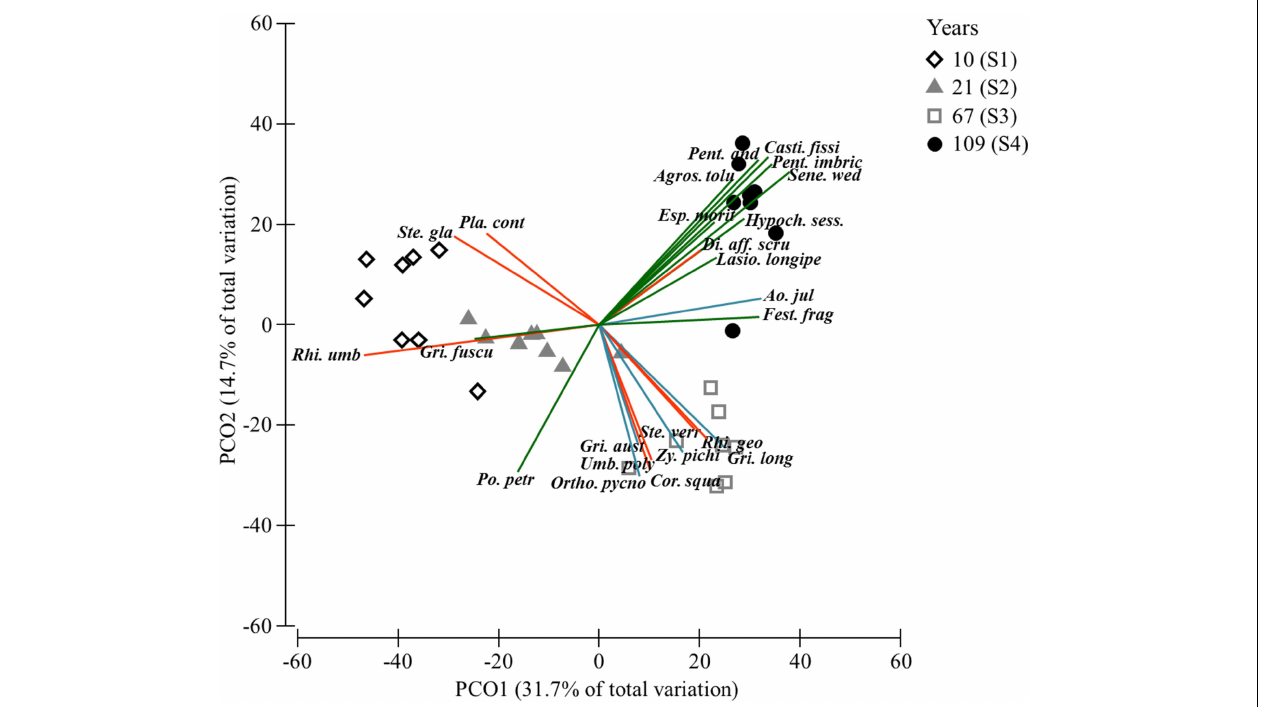
FIGURE 3 | Principal Coordinates Analysis based on a Bray–Curtis similarity matrix of the cover of all species present in 5 × 5 m plots ( n = 32) in four study sites (S1-S4) along a post-glacial chronosequence at Humboldt Peak, Venezuela. The vectors correspond to the Spearman Rank correlation (r s ≥ 0.5) of the dominant species of lichenized fungi (red), bryophytes (blue) and vascular plants (green) with the first two principal axes (full species names in Supplementary Table 2 ).